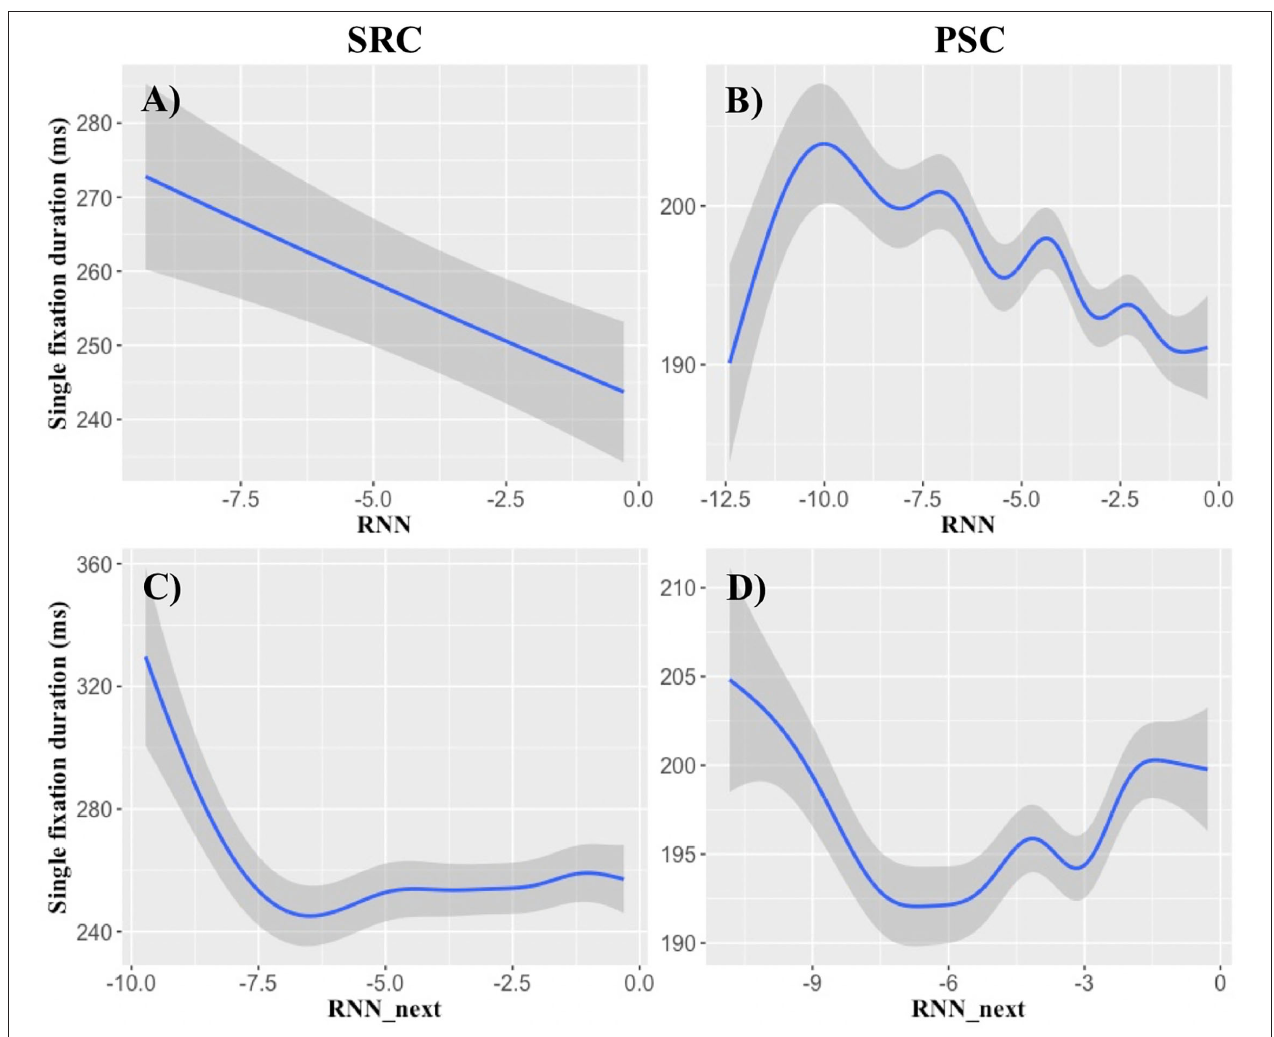
FIGURE 3 | RNN probability effects on single-fixation durations. X-axes show log-transformed RNN probabilities, while the y-axes demonstrate the most reliable present and next-word RNN effects obtained in single-fixation durations. The (A,B) demonstrate the effect of present-word RNN probability. Relatively linear decreases of single-fixation durations are obtained, particularly at a log-RNN probability of − 10 and higher. (C,D) Illustrate the effects of log RNN probability of the next word. Log RNN probabilities of the next word lower than − 7 seem to delay the fixation duration of the currently fixated word. (A,C) show SRC data and (B,D) illustrate PSC data. Shaded areas indicate standard